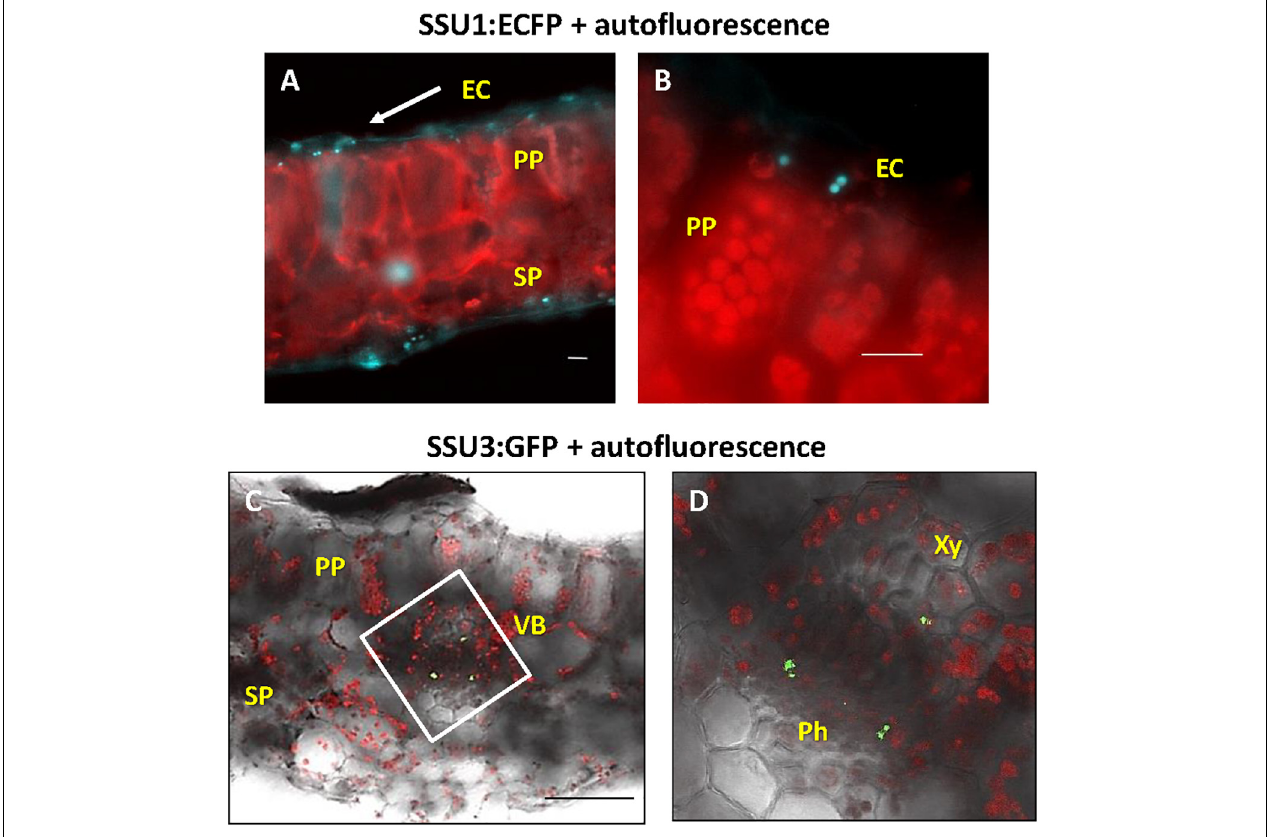
FIGURE 5 | Localization of the small IPMI subunits in leaves. (A,B) IPMI SSU1:ECFP-positive plastids (cyan) locate to the leaf epidermis. (B) the epidermal cells (EC) contain small plastids with longitudinal diameter of 4–5 µ m. In comparison, chloroplasts (red autofluorescence) of mesophyll cells [palisade parenchyma (PP) and sponge parenchyma (SP)] are 7–8 µ m in size. (C,D) Cross section through a leaf vascular bundle (VB) revealed IPMI SSU3:GFP in cells located proximal to both phloem (Ph) and xylem (Xy), respectively. Scale bars: (A,B) 20 µ m, (C) 100 µ m. (D) is a magnification of the white boxed part of the image shown in (C)